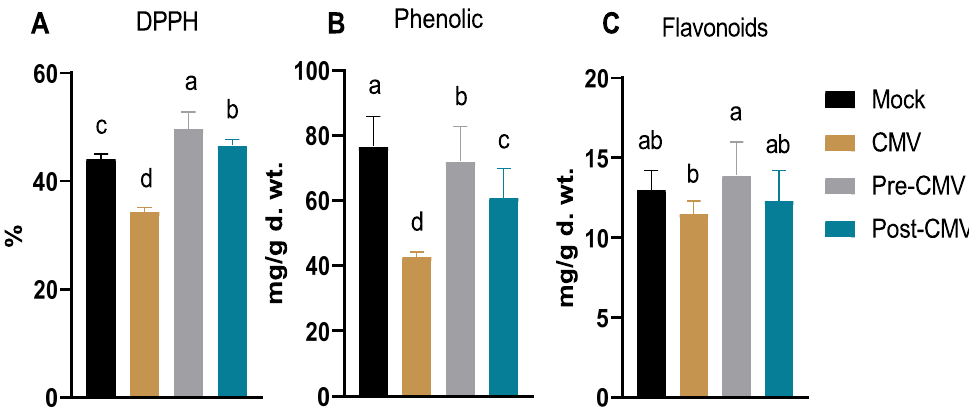
Figure 7. The impact of Ag-NPs foliar application on free radical scavenging activity using DPPH ( A ), total phenolic ( B ), and flavonoid contents ( C ) in squash plants. Mock: plants inoculated with viral inoculation buffer; CMV: plants mechanically inoculated with CMV; Pre-CMV: plants treated with Ag-NPs, 24 h before CMV inoculation; Post-CMV: plants treated with Ag-NPs, 24 h after CMV inoculation. Statistically, there is no variation between the means of the columns that share the same letter.